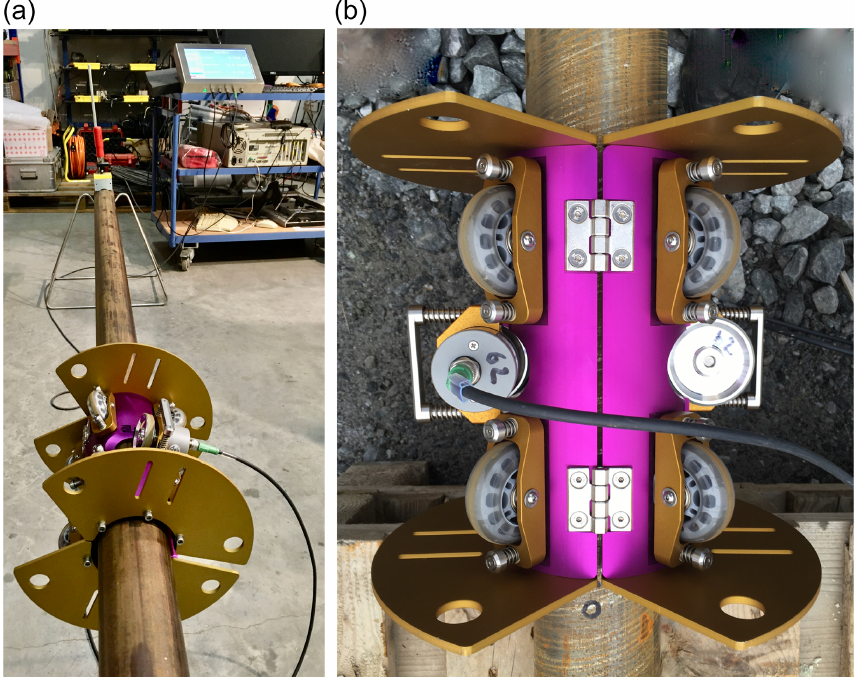
Figure 4. (a) A photo of the testing of the depth-measuring system iDMD-W mounted on a HQ drill pipe under lab conditions. (b) A close-up of the iDMD-W. The two depth-counting wheels are in the middle on opposite sides, and four of the eight guide wheels are visible above and below, all mounted on the magenta-colored sleeve. The brass-colored side flanges are used to attach the iDMD to the